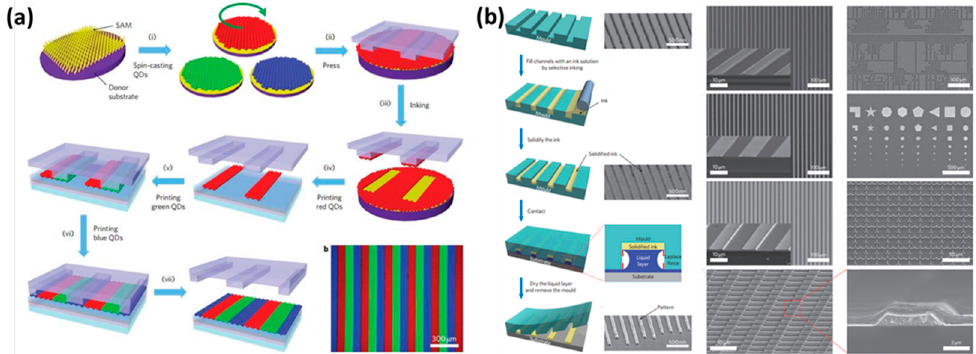
Figure 2. ( a ) The processing steps of micro-contact printing. Functional materials on the modified surface could be adhered to the printing stamp, and then the functional materials are deposited on specific regions of surfaces. Functional material patterning formation. Reproduced from [44], with permission from Macmillan Publishers Ltd., 2011; ( b ) The processing steps of transfer printing. Left: Ink filling in the templates and transferring with a high-resolution. Right: Patterned functional micro-nano structure. Reproduced from [45], with permission from Macmillan Publishers Ltd., 2011.